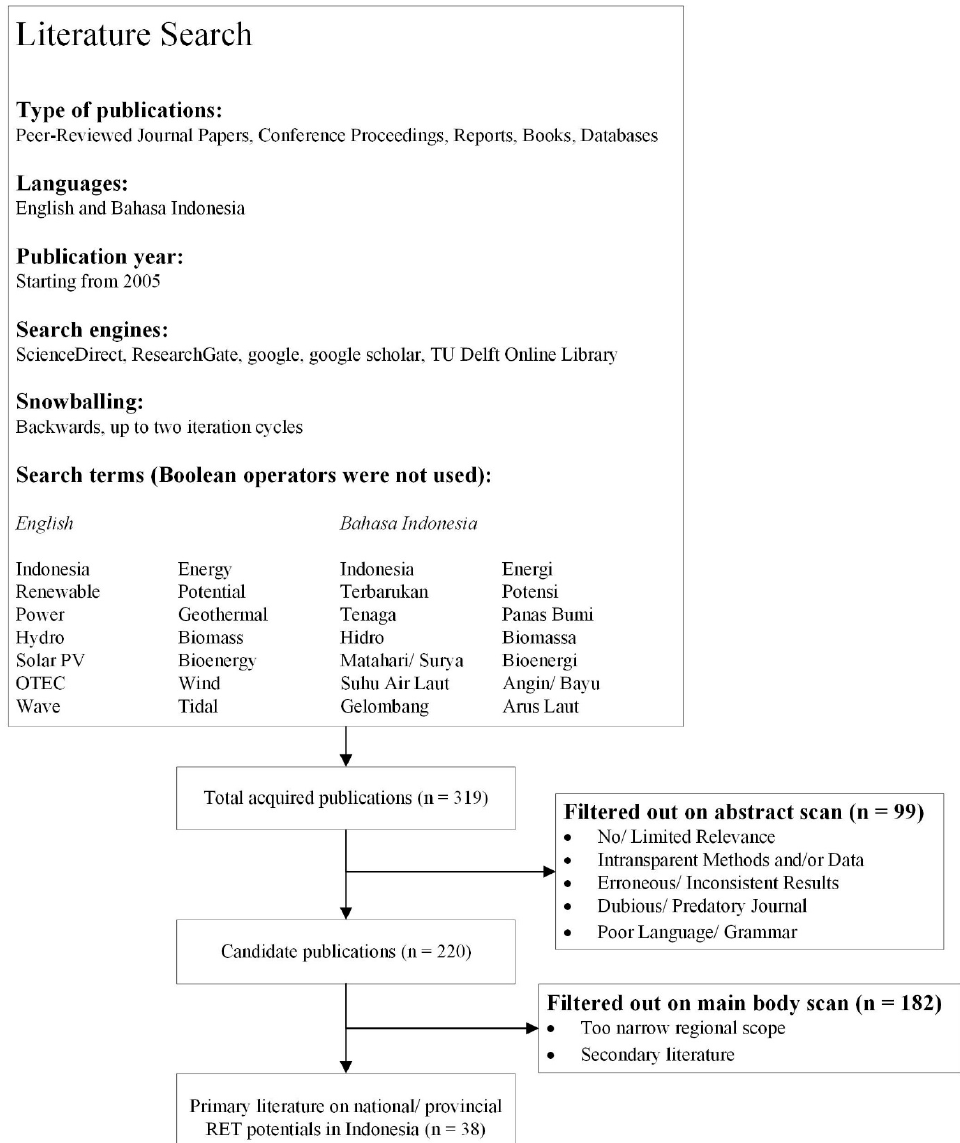
Figure 1. Methods used for the systematic literature review on RET potentials in Indonesia.